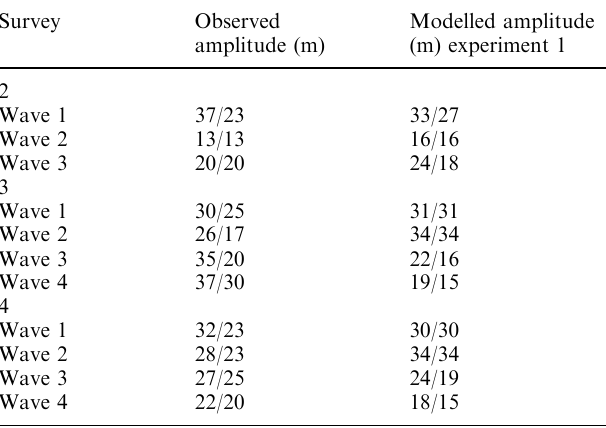
Table 4a. Comparison of observed (Table 1) and modelled amplitudes of the leading waves in the bore. All amplitudes peak-trough, for each side of the wave, largest first Survey